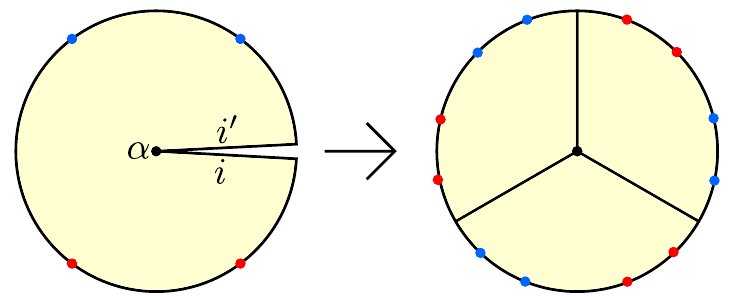
Figure 3 . Cutting open the n = 1 gravitational path integral (left) and gluing together 3 copies to form a path integral for computing the third boundary Renyi entropy (right). Red dots are the sources which produce the \ket" part of the density matrix, while blue dots are their CPT conjugates which produce the \bra" part. The HRT surface (cid:13) R is represented by the black dot in the center, and is shared between all copies in the Renyi